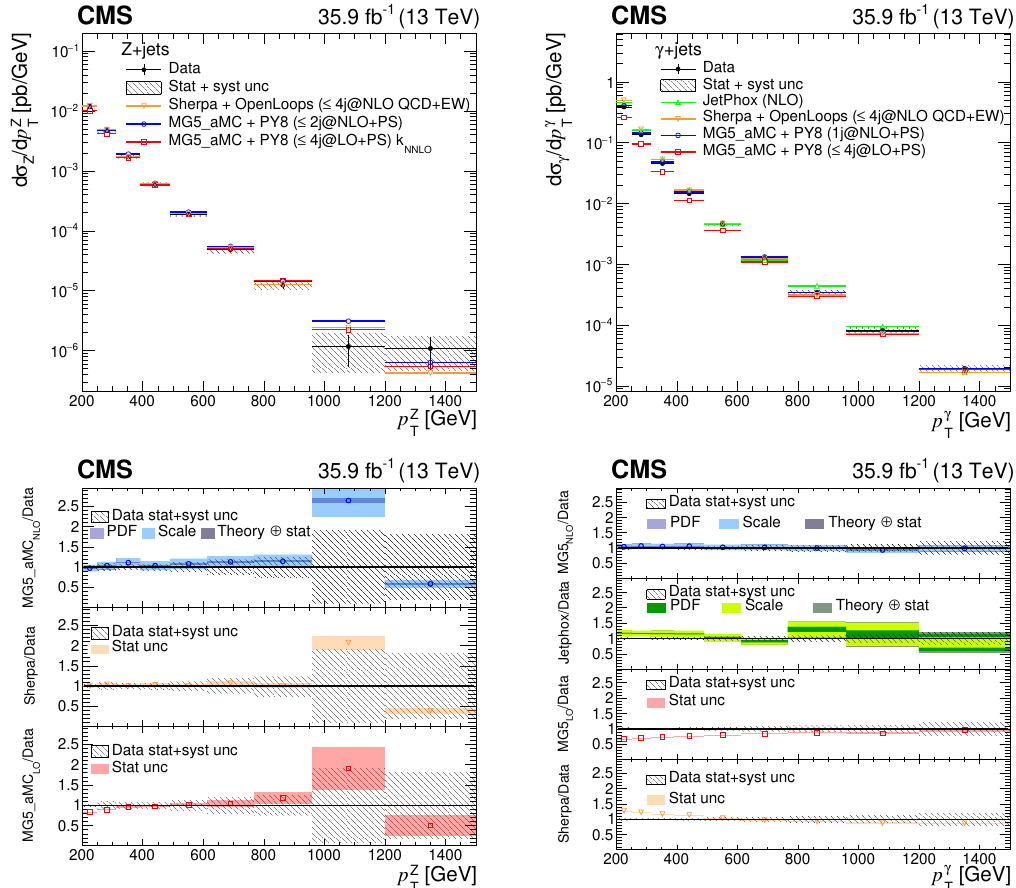
for Z + jets (left) Figure 2 . Measured differential cross sections as a function of the boson p T and γ + jets (right) and their comparisons with several theoretical predictions. The LO Mad- Graph 5_a mc@nlo prediction for Z + jets has been normalized to the NNLO cross section (de- noted by k ). The vertical bars in the upper panels represent the statistical uncertainty in NNLO the measurement and the hatched band in the lower and upper panels is the sum in quadrature of the statistical and systematic uncertainty components in the measurement. The lower panels show the ratios of the theoretical predictions to the unfolded data. The shaded band in the LO MadGraph 5_a mc@nlo and sherpa + OpenLoops calculations shows the statistical uncertainty. The dark (light) shaded band on the NLO prediction from MadGraph 5_a mc@nlo and the Jet- Phox prediction represents the PDF (scale) uncertainties, whereas the statistical uncertainties are barely